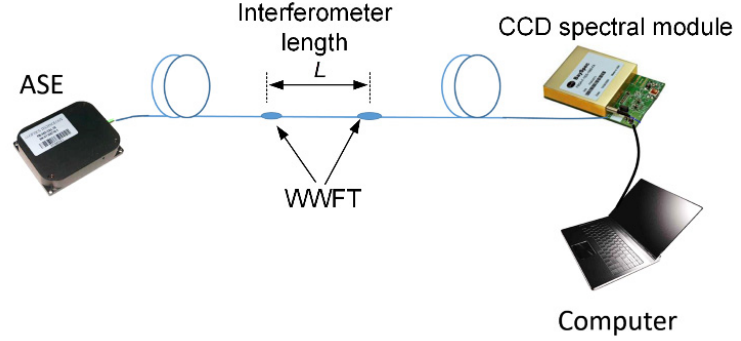
Figure 2. Experiment setup of WWFT-based interferometer. ASE: amplified spontaneous emission, CCD: charge-coupled device, WWFT: weak waist-enlarged fiber taper.